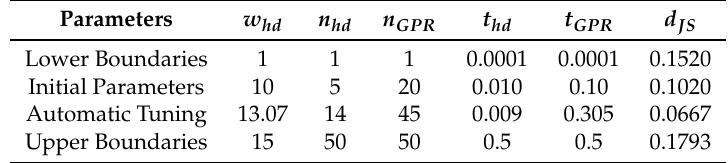
Table 1. Initial and optimum parameters together with the associated JS divergence values. Parameters